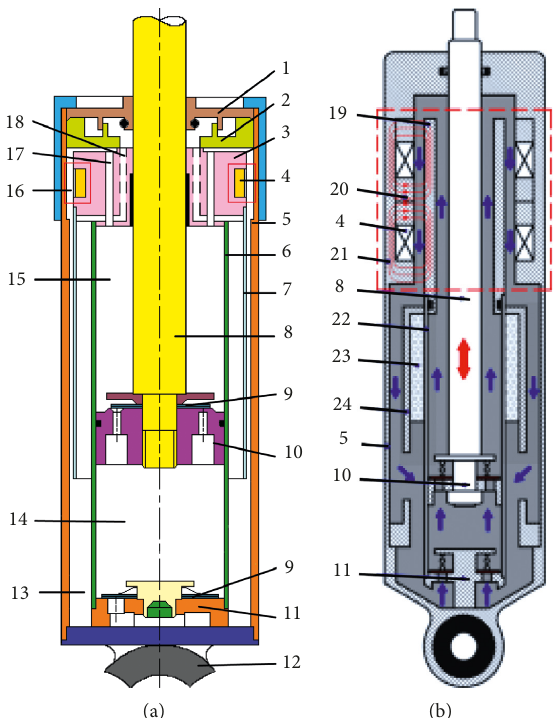
Figure 14: Schematic of pumping magnetorheological damper: (a) single-coil type [57]; (b) double-coil type [58]:1, seal; 2, seal seat; 3, guide assembly; 4, coil; 5, outer cylinder; 6, main cylinder; 7, guide cover; 8, piston rod; 9, one-way valve; 10, piston; 11, foot valve; 12, mounting bushing; 13, oil reservoir; 14, compression chamber; 15, rebound chamber; 16, active area; 17, pressure relief channels; 18, reflux channels; 19, inner magnetic path; 20, middle magnetic path; 21, outer magnetic path; 22, inner cylinder; 23, gas chamber; 24, middle